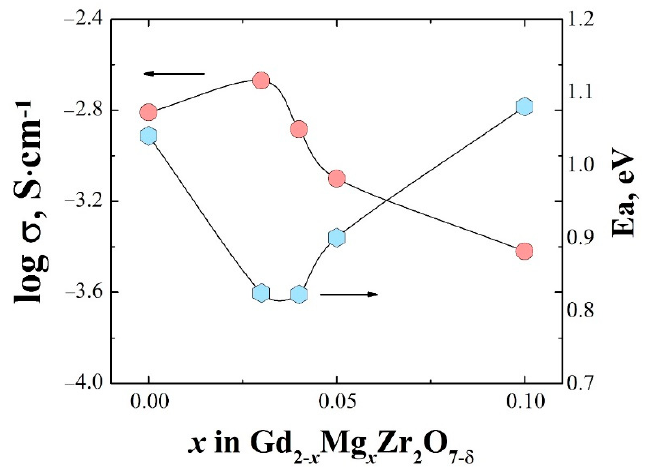
Figure 7. Concentration dependence of bulk conductivity and activation energy for Gd 2 − x Mg x Zr 2 O 7 − x/2 at 640 ◦